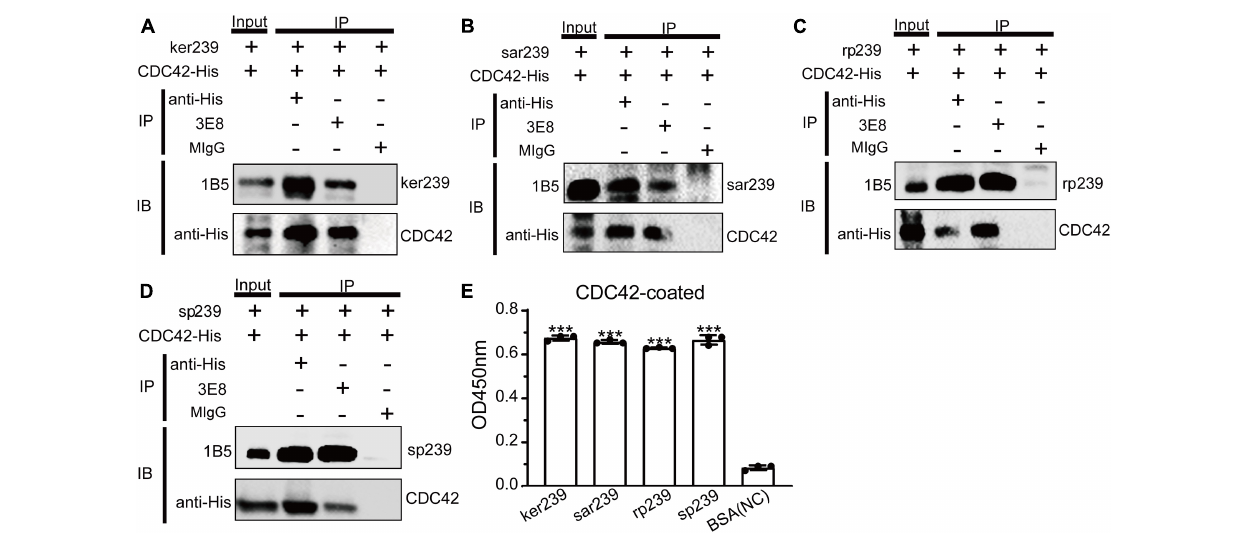
FIGURE 5 | CDC42 interacts with truncated capsid proteins of mammalian HEV. It was pulled down from each other using 3E8 mAb or anti-His mAb that CDC42-His and ker239 from genotype 3 HEV Kernow C1/p6 strain (HEV-3) (A) , sar239 from genotype 1 HEV Sar55 strain (B) , sp239 from the genotype 4 HEV CHN-SD-sHEV strain (C) , and rp239 from genotypes 3 HEV CHN-SX-rHEV strain (D) . MIgG was set as a blank control. Out of 600 µ L of total proteins, 40 µ L was set as the input group, and the additional proteins were trisected and used for pull-down assays. (E) ELISA results of CDC42-His directly binding with different HEV capsid proteins. Plates were coated with CDC42-His and incubated with ker239, sar239, rp239, and sp239. *** P <